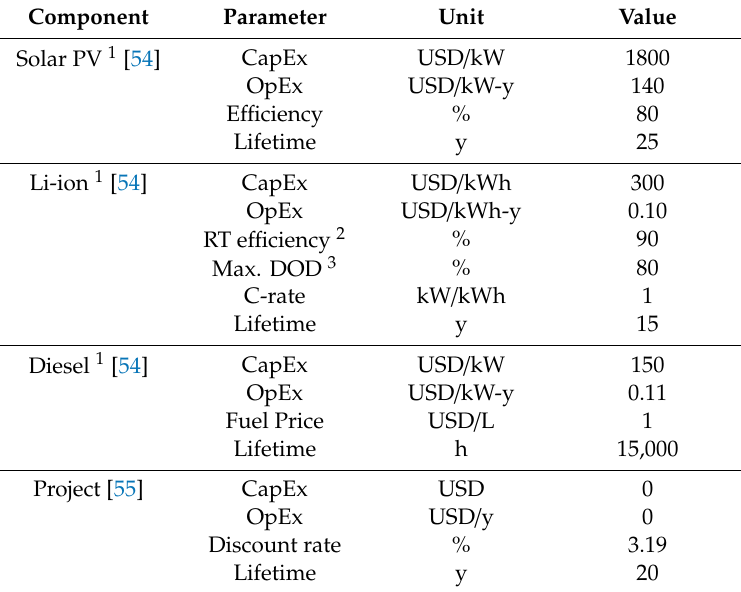
Table A2. Techno-economic parameters used in the simulations.